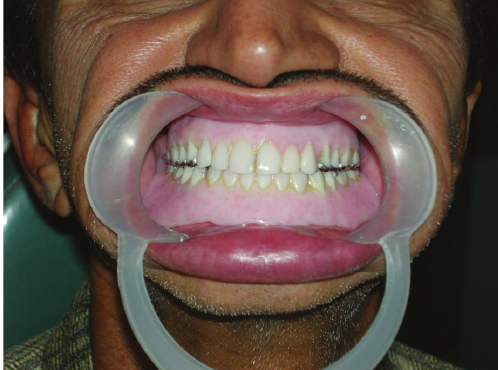
Figure 4: Postoperative intraoral view: denture insertion with metal occlusal surfaces on posterior teeth.